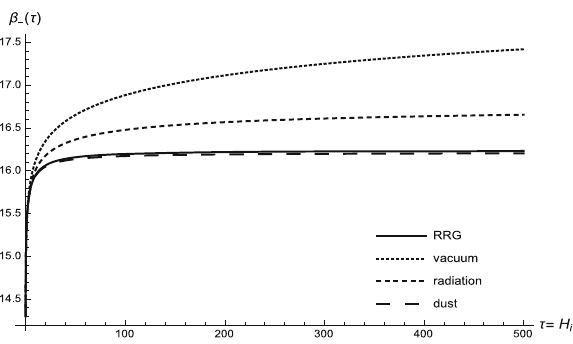
Fig. 8 Plots of β − for the moderate warmness. Parameters are as fol- ( i ) = 0 . 99 while the initial condition is β − = lows: b = 0 . 5, Ω ani